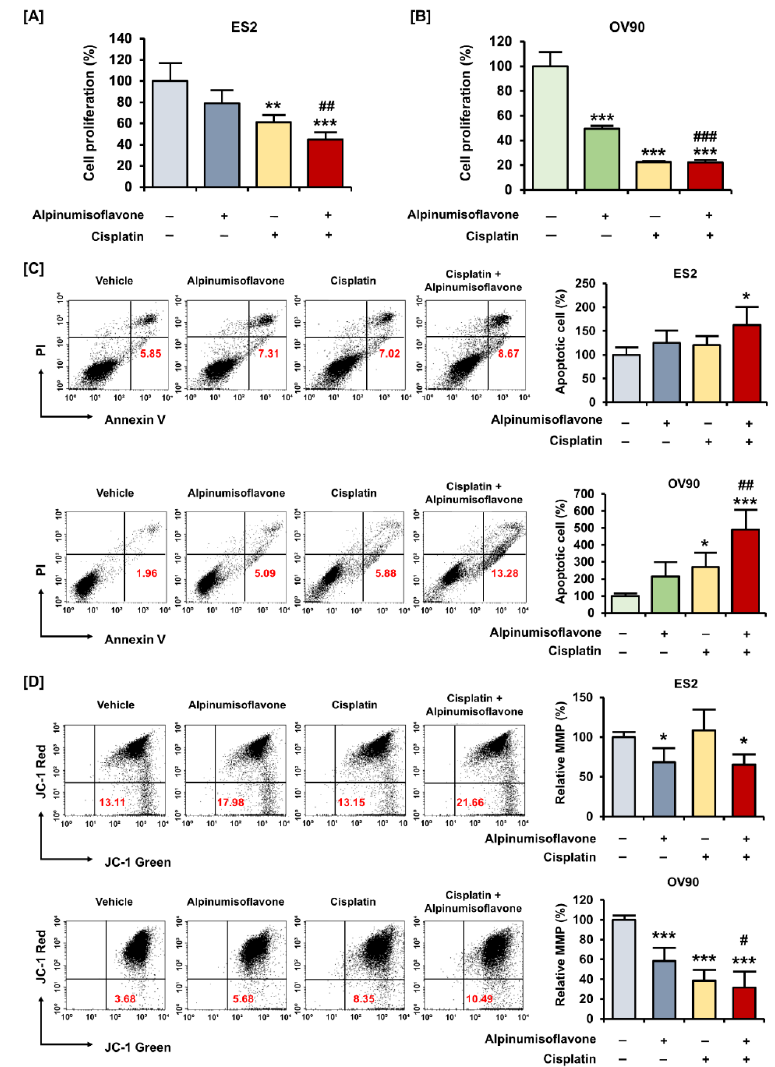
Figure 5. Alpinumisoflavone with cisplatin exhibited synergistic effects on suppression of prolifer- ation of ovarian cancer cells. ( A , B ) A cell proliferation assay was used to detect the proliferation of ES2 and OV90 cells in response to cisplatin, with or without alpinumisoflavone treatment, for 48 h. ( C ) Apoptosis of ES2 and OV90 cells in response to cisplatin (4 μM), with or without alpinumisofla- vone (2 μM), was investigated using annexin V and PI. Relative late apoptotic cells are presented as bar graphs compared to the vehicle-treated cells (100%). ( D ) A JC-1 assay was conducted to study the effect of alpinumisoflavone, or a combination of alpinumisoflavone with cisplatin, on MMP. The MMP condition is indicated by the quadrant of the dot blot using flow cytometry. All experiments were performed in triplicate. The level of significance between the vehicle and treatment groups is depicted by asterisks (* p < 0.05, ** p < 0.01 and *** p < 0.001). The level of signifi- cance between alpinumisoflavone and the co-treatment groups is depicted by crosshatch ( # p < 0.05, ## p < 0.01 and ### p <